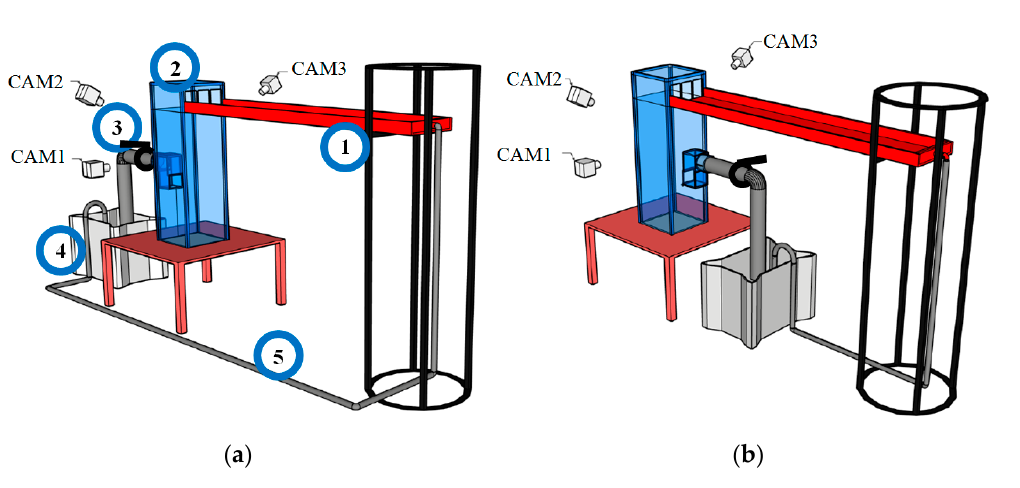
Figure 2. Experimental setup and camera positions 1. Aluminium canal 2. Gully pot 3. Control valve.